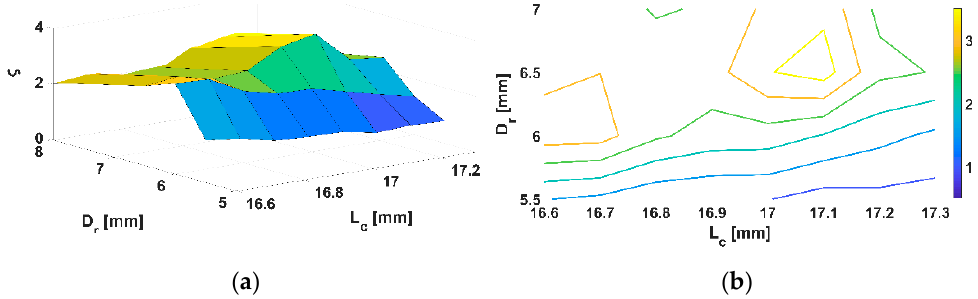
Figure 8. Relative PA signal of the combined sweep of L c and D r ( a ) along with a contour plot ( b ). The color scale gives the values of ς .